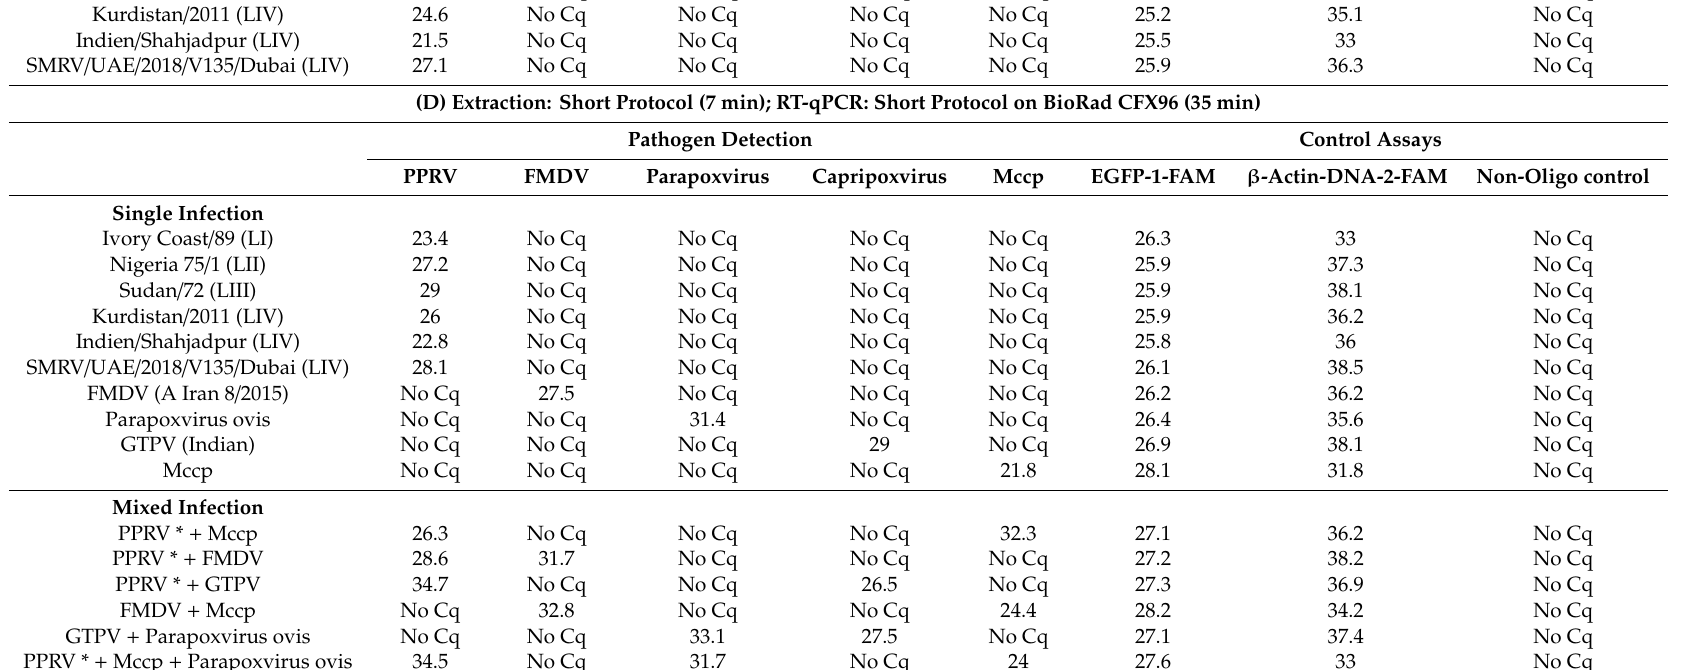
PPRV * + Mccp + Parapoxvirus ovis